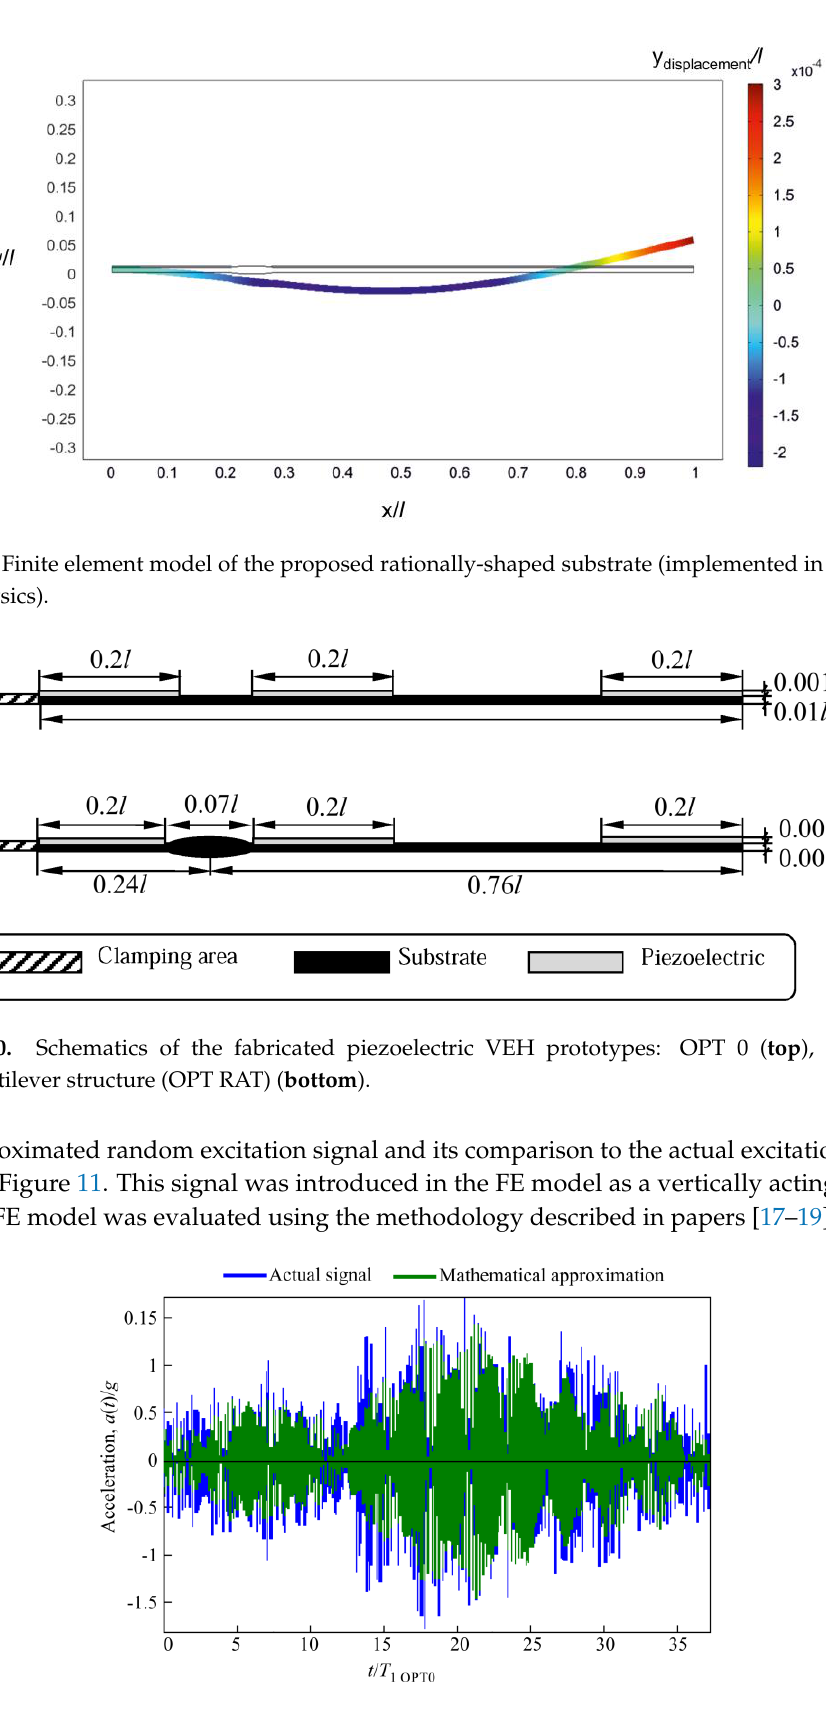
Figure 11. Comparison or real ( blue ) and approximated ( green ) random excitation signals (R 2 = 0.7869).